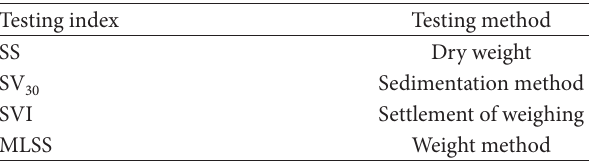
Table 3: Testing index and method of activated